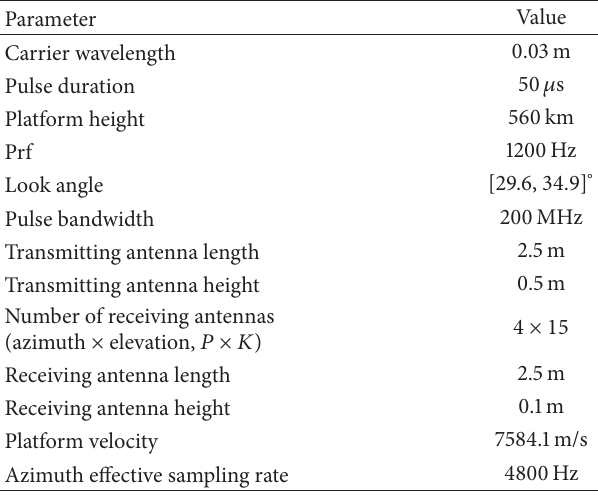
Table 1: Simulation system